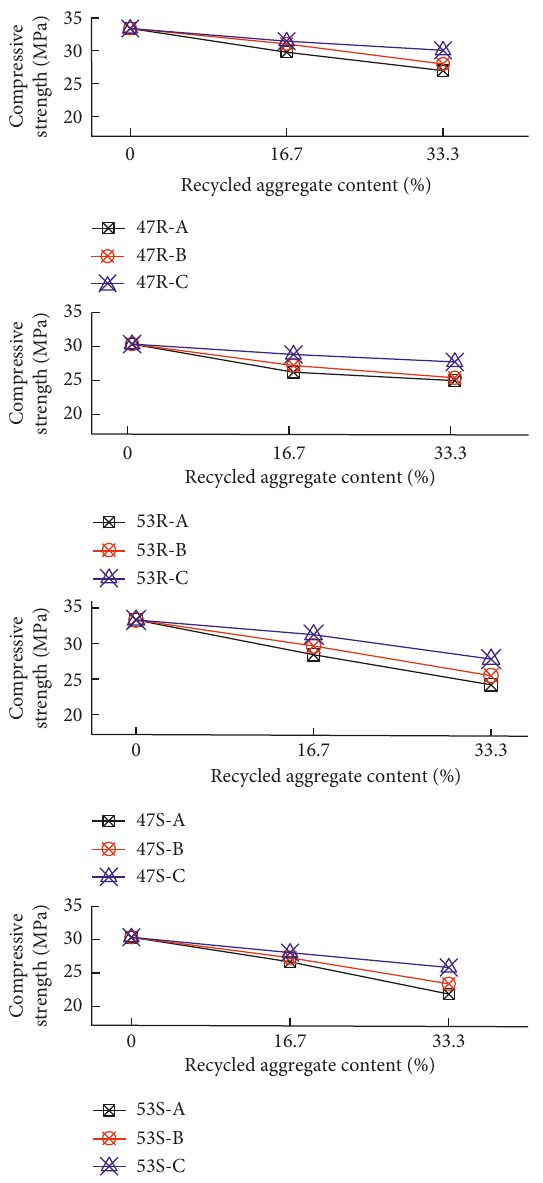
Figure 5: Relationship between the compressive strength and recycled aggregate content at the same aggregate type and water/cement ratio.